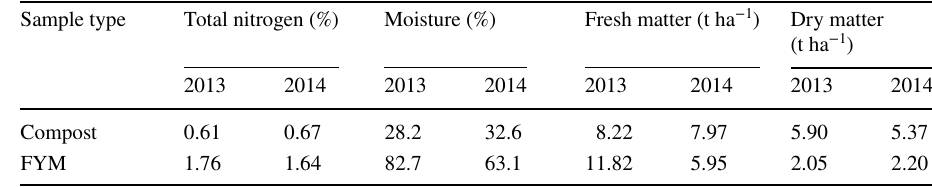
Fig. 2 Monthly total for 2013 and 2014 cropping seasons, and 35 years average rainfall at Lemu-Bilbilo district in southeastern Ethi- opian highlands Table 1 Properties and amounts of compost and farmyard manure used in the field